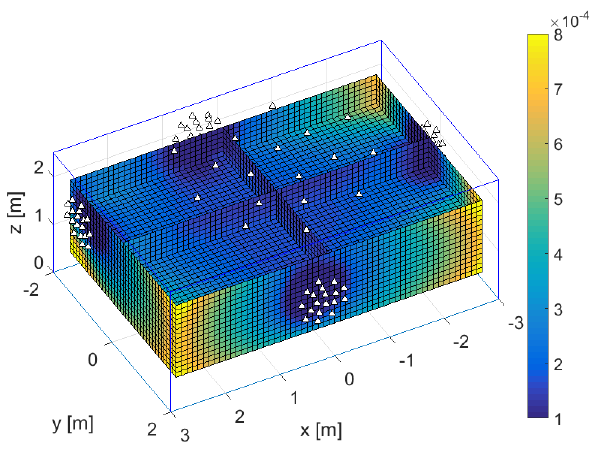
√ Figure 2. CRB/ λ c of 3D localization inside a room of size 6 m × 4 m × 2.5 m with 18 antennas on each wall and the ceiling, all marked with triangles. The obtained CRB is for a random Gaussian sequence and parameters SNR 0 = 25 dB, N = 1024, f c = 60 GHz/100